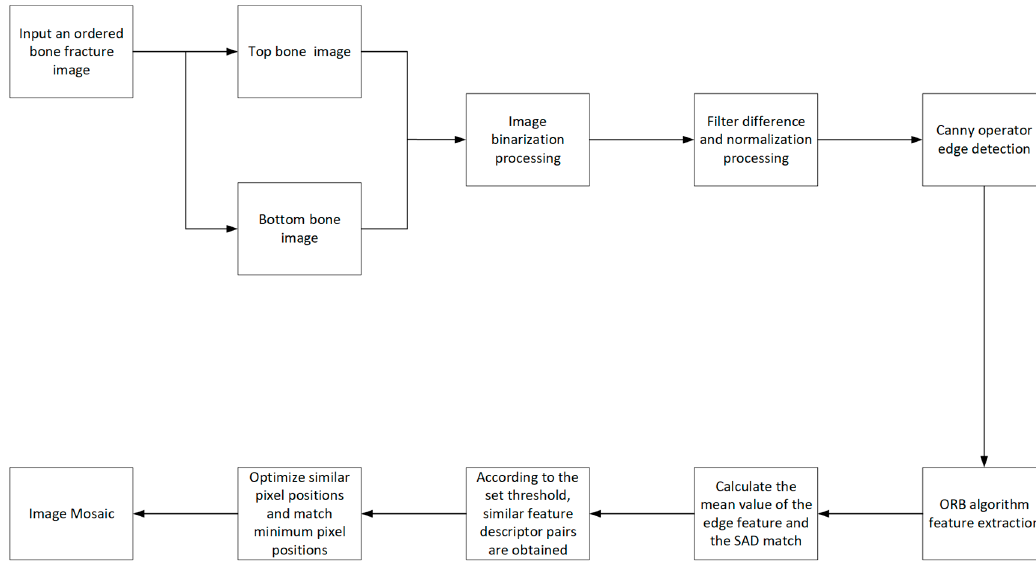
Figure 1. Algorithm flow.